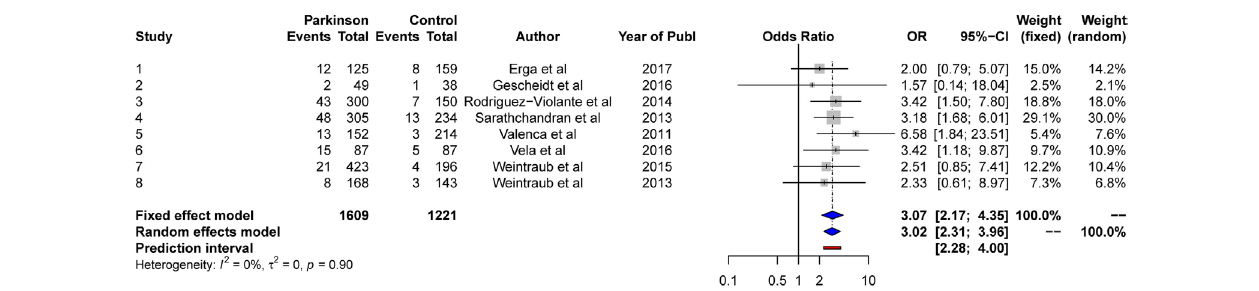
FigURe 11 | Forest plot for punding.